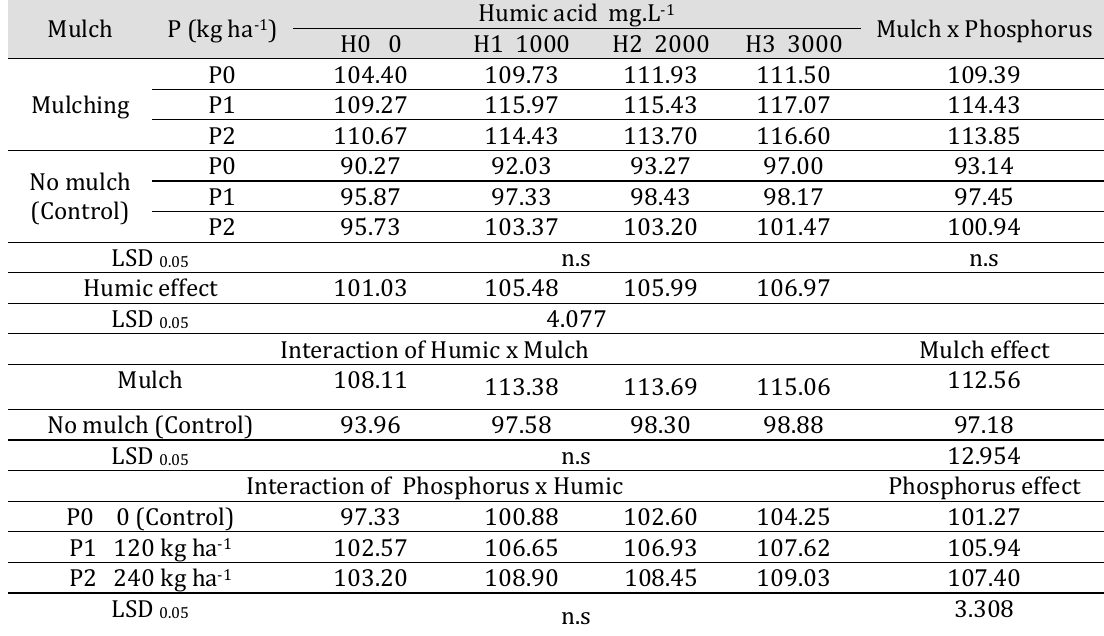
Table 2. Effect of soil mulching, phosphorus, humic acid, and interactions on plant height (cm).